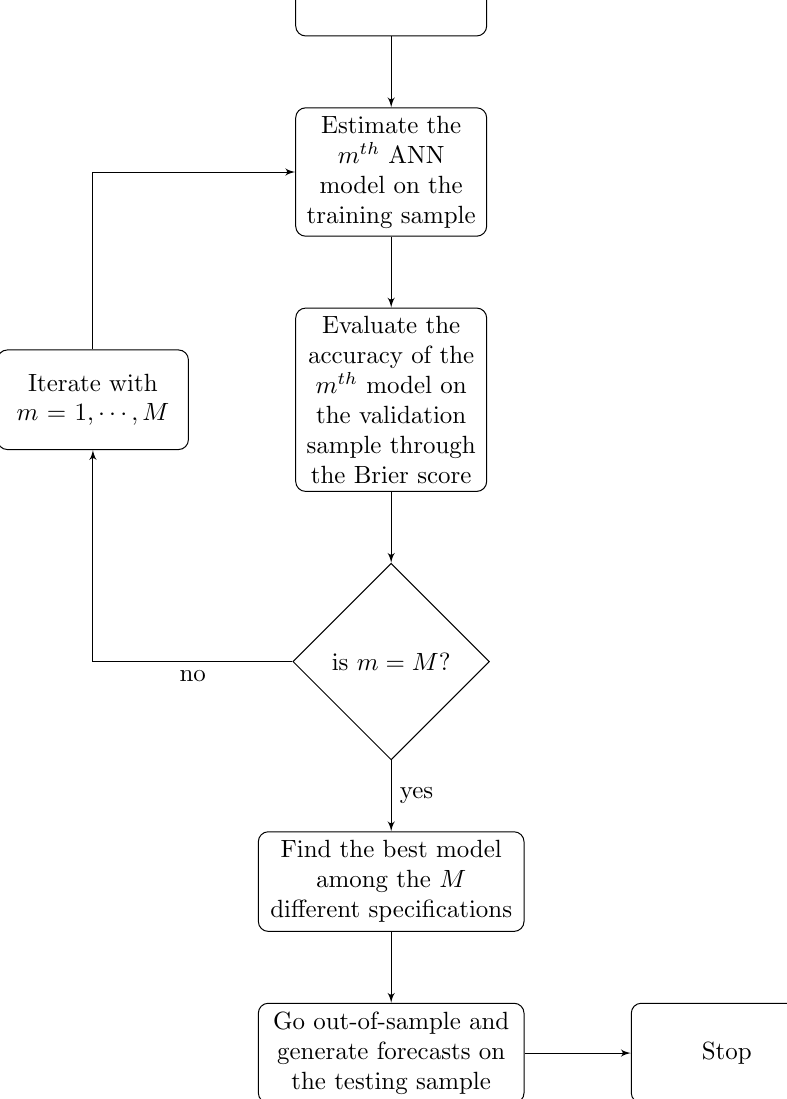
Figure 2. Summary diagram of the ANN estimation. Note: The figure shows the estimation, validation, and testing procedures of the m th ANN model, with m = ANN specifications evaluated in the validation